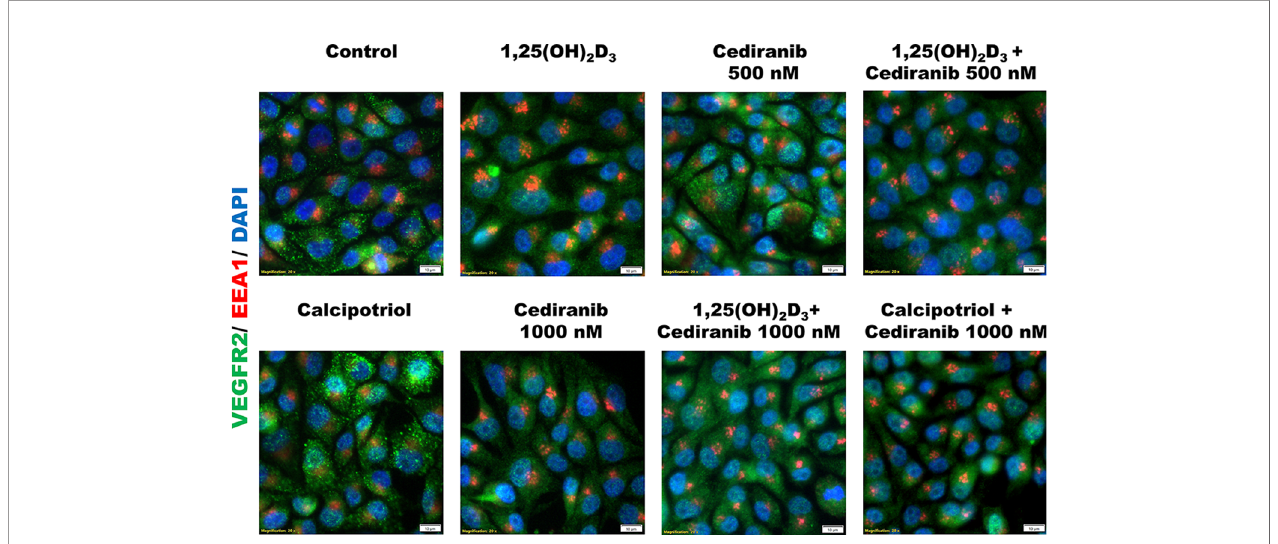
FIGURE 7 | Immuno fl uorescent detection of VEGFR2 (green) or EEA1 (red) in A375 melanoma cells. Melanoma cells were preincubated with vitamin D derivatives for 24 h and subsequently treated with cediranib at 500 or 1,000 nM concentration for another 24 h. Nuclei were counterstained with DAPI (shown in blue). Magni fi cation